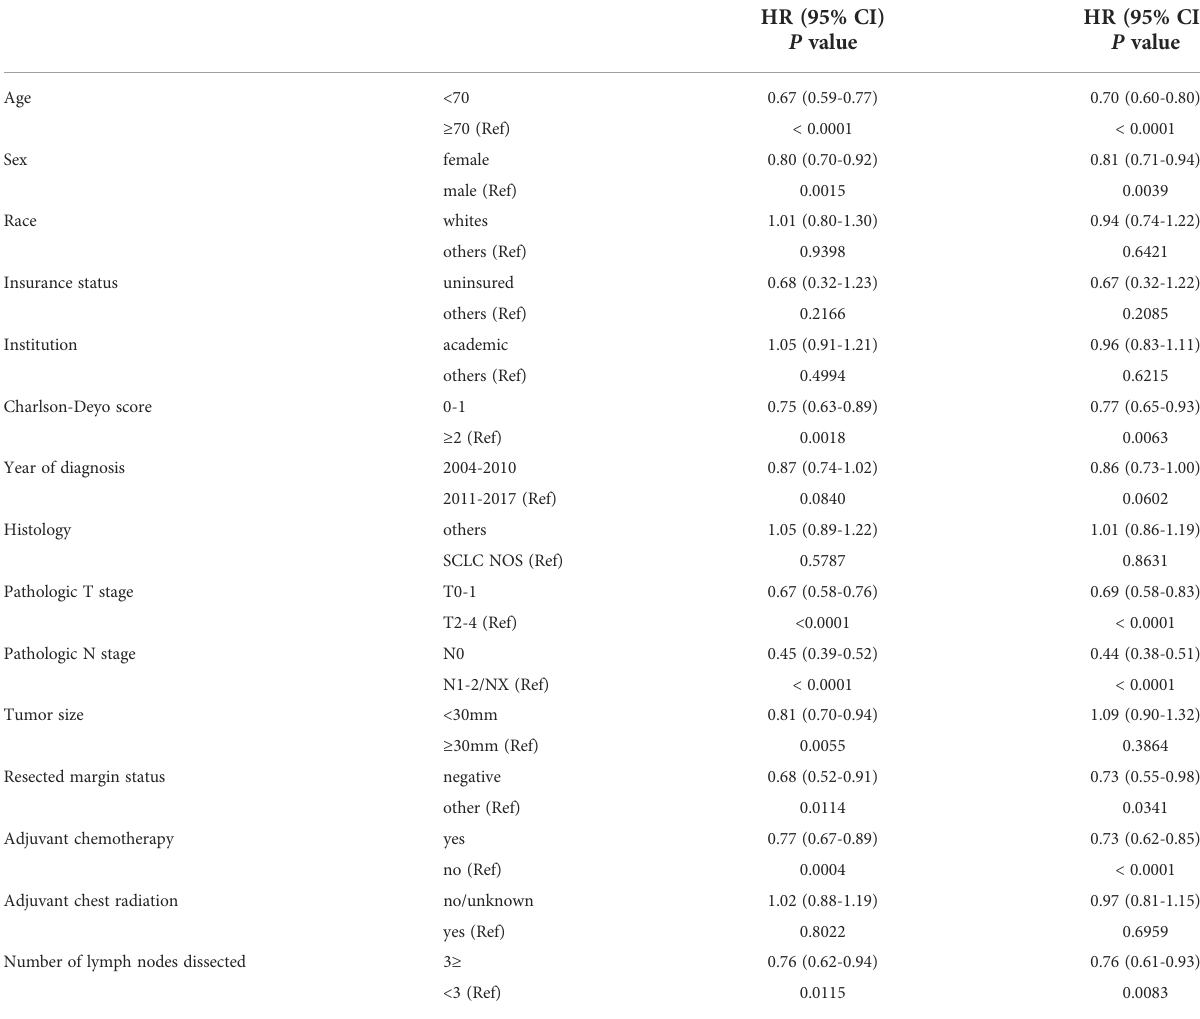
TABLE 3 Multivariable analyses of overall survival in patients with resected clinical stage I-II (AJCCv7) small cell lung